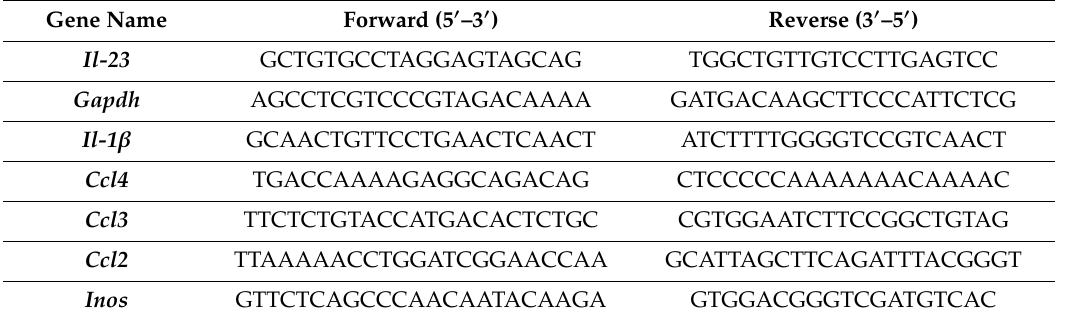
Table 2. Primers used in this